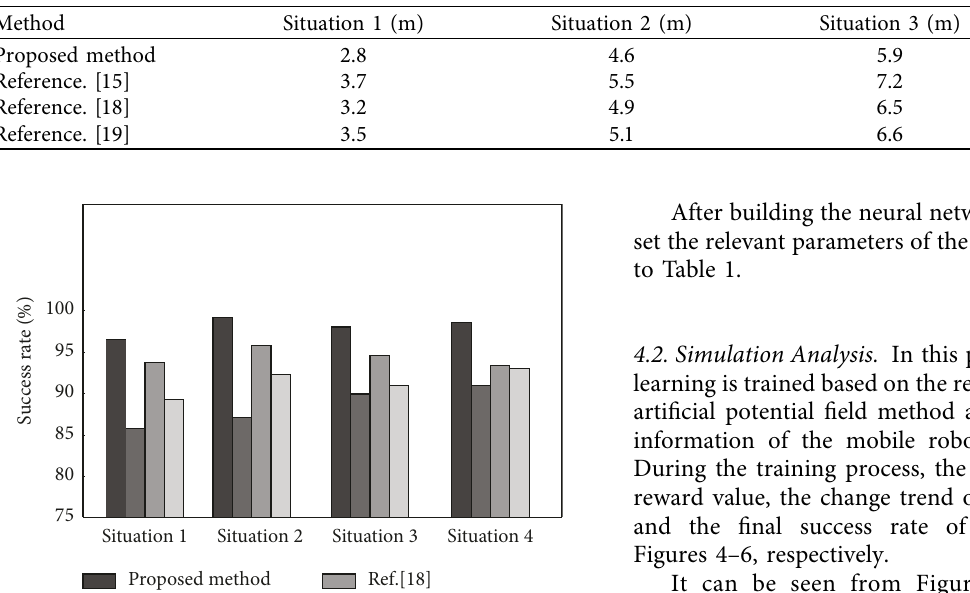
Table 2: The total length of paths planned by different algorithms in different situations.